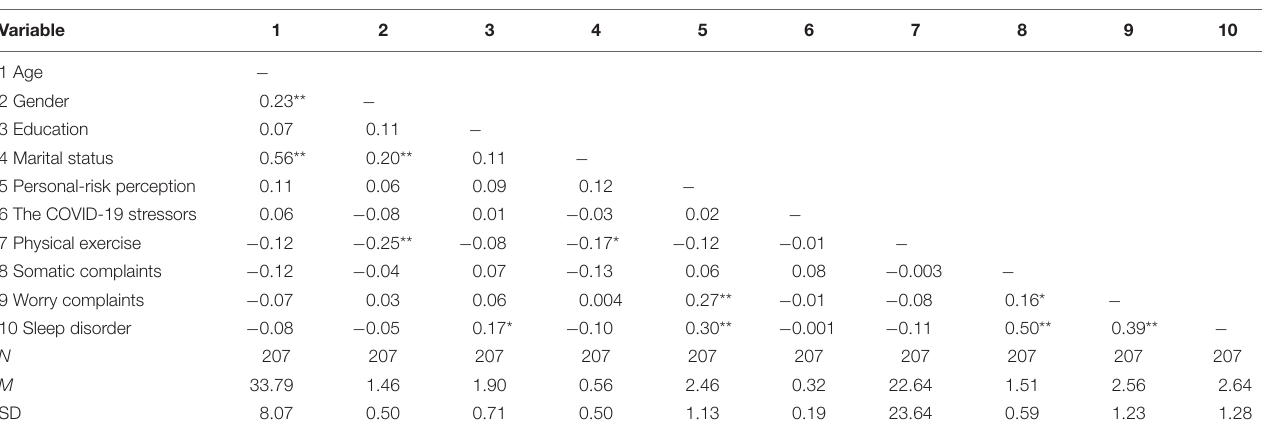
TABLE 1 | Descriptive statistics and intercorrelations of study variables.